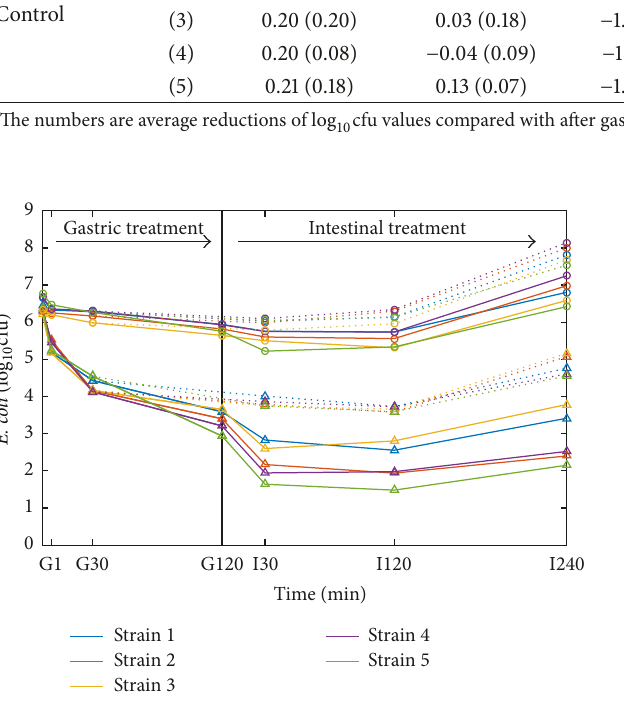
Figure 3: Counts of E. coli during digestion challenge. Salami batter with starter culture fermented at 20 ∘ C for 21 days and thereafter stored for 24 h at 4 ∘ C ( 󳵻 ) and control batters without starter culture which were held at 4 ∘ C for 22 days ( I ) are shown. Exposure of samples to gastric acid (gastric treatment; G) for 30 or 120 min and subsequently to intestinal fluid (intestinal treatment; I) for 240 min is according to Table 2. Dotted and continuous lines represent samples exposed to 30 and 120min of gastric treatments, respectively, before intestinal treatment. Average values from three independent experiments with two parallels each are given, and strains are numbered according to Table